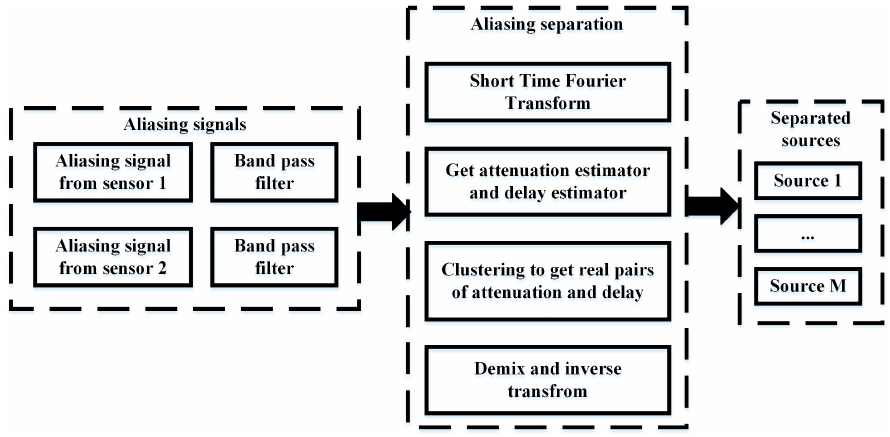
Figure 3. Flow chart of aliasing signals separation.